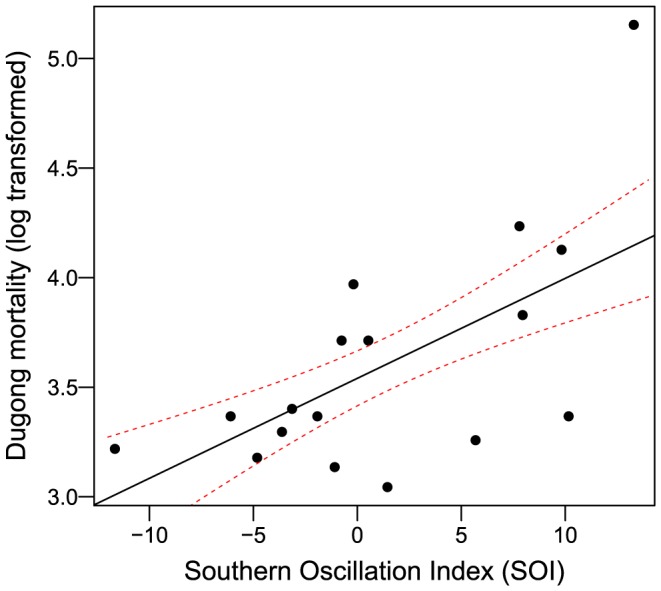
Relationship between annual natural mortality of dugongs and ENSO (SOI, annual average).The model was fit using robust regression (dotted red lines: 90% confidence intervals) and the outlier at the top of the graph is from 2011.